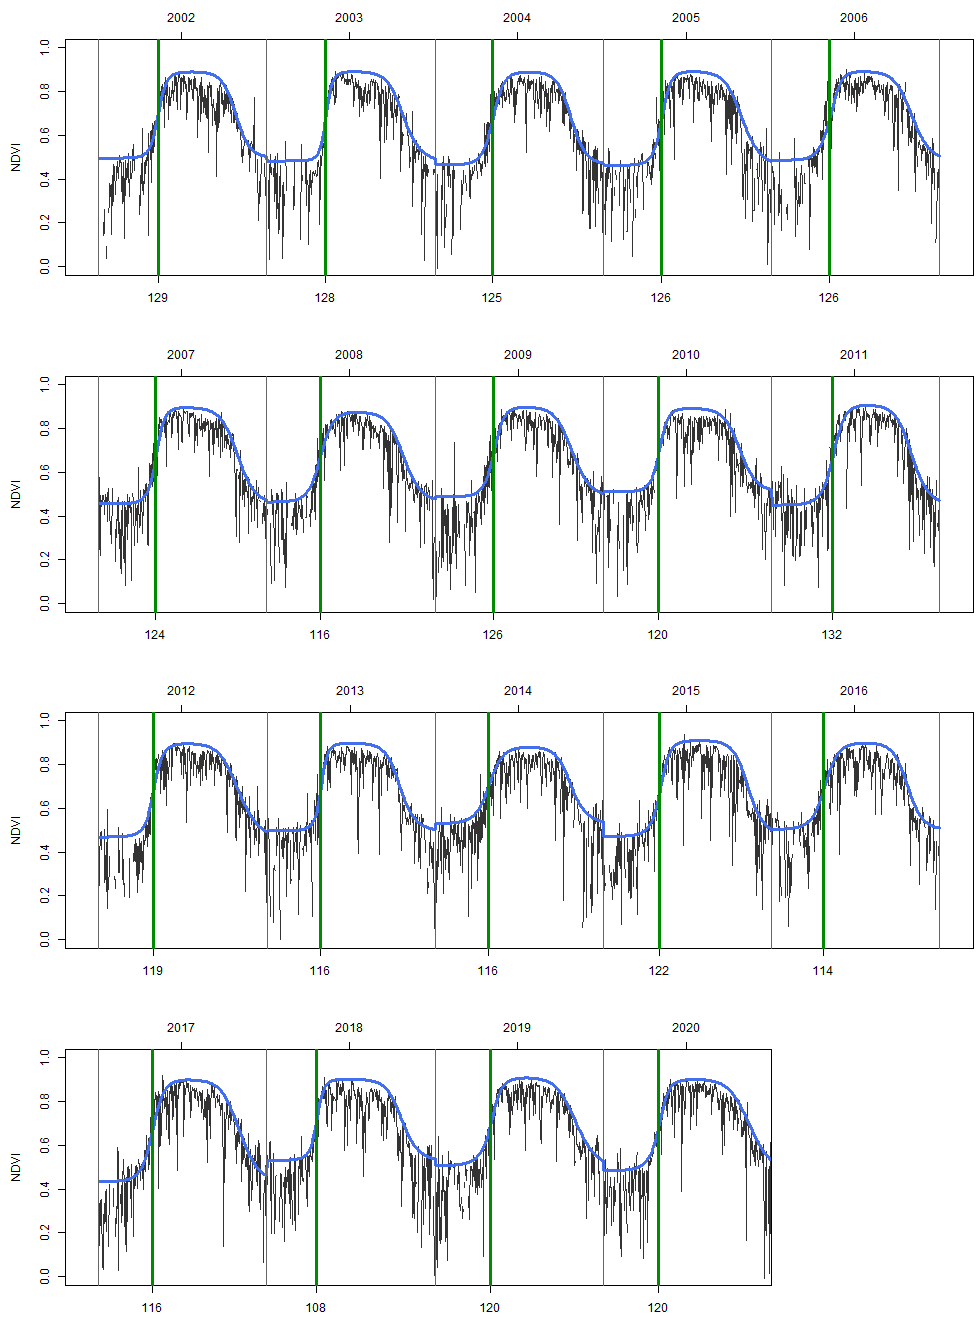
Figure 3. Mean raw NDVI time series (black lines), mean fitted curve (blue lines), and mean SOS dates of individual years (green lines) over the study period (2002 – 2020).